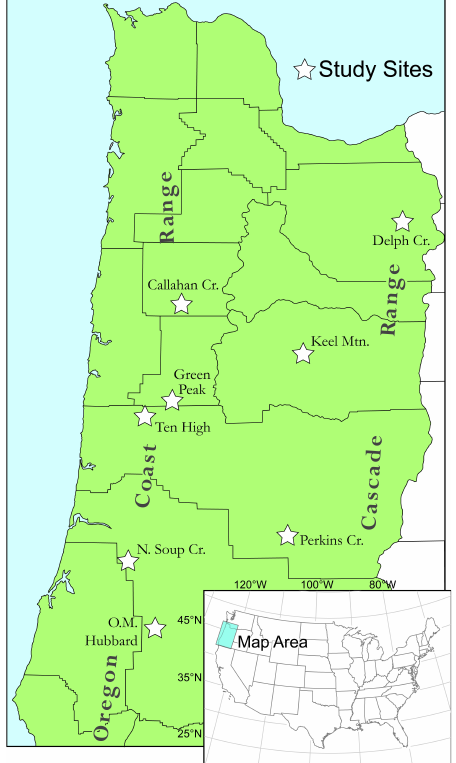
Figure 1. Locations of eight Density Management and Riparian Buffer Study sites in western Oregon, USA, where we examined the effects of a second-thinning harvest with different riparian buffer management designs on instream and stream bank aquatic-dependent